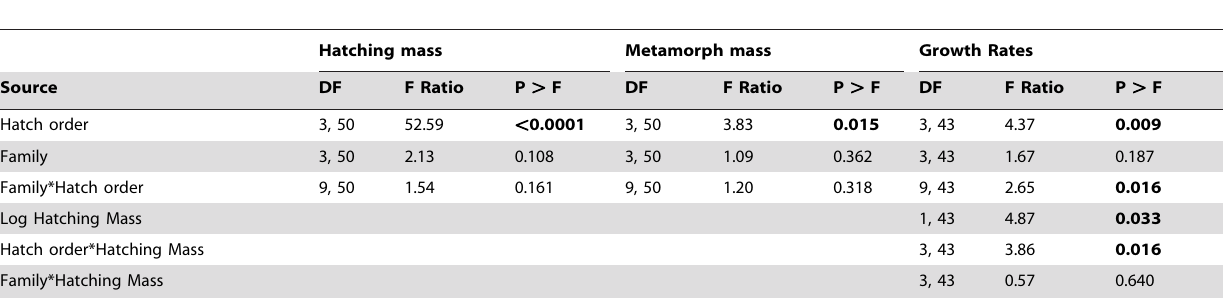
Table 1. F-statistics and P-values for general linear models of hatch order and family associations hatching mass, mass at metamorphosis and logistic growth